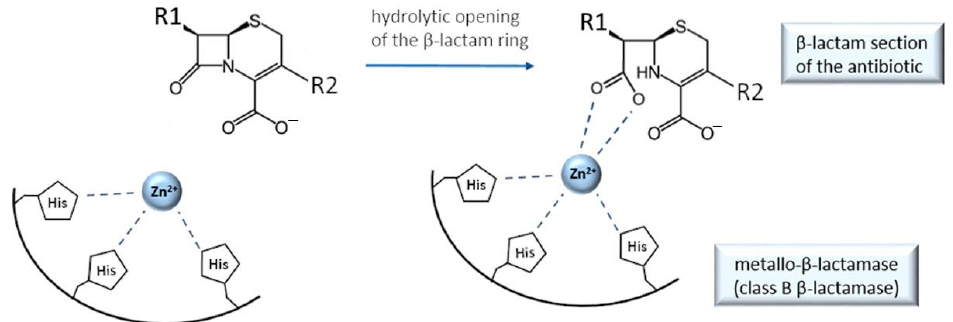
Figure 12. Simplified scheme of metallo- β -lactamase catalytic mechanism, depicting the role of chelation in disabling the action of β -lactam antibiotics (inspired by ref. [71]). For clarity, only one out of two Zn 2+ ions are